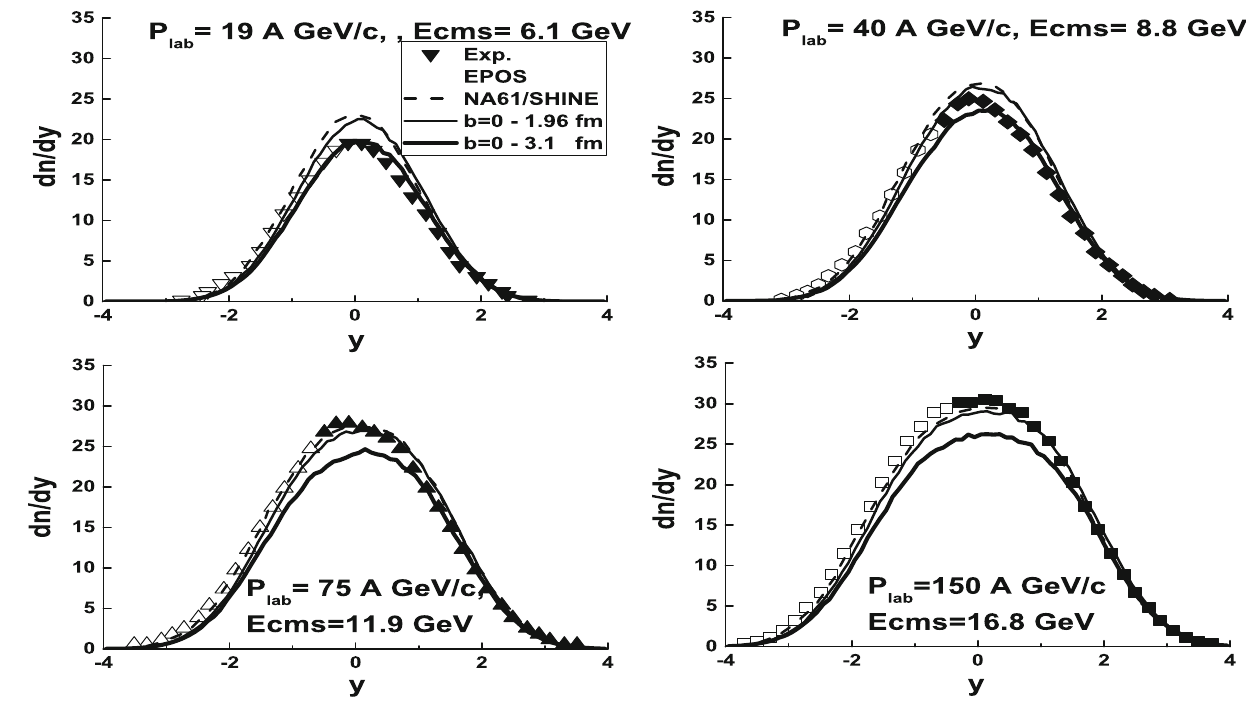
Fig. 3 Rapidity distributions, d n /d y , of π − mesons. The black points are the data measured by the NA61/SHINE collaboration for 0–5% centralities. The open points are the values extrapolated by the col- laboration into an unmeasured region. The EPOS model calculations